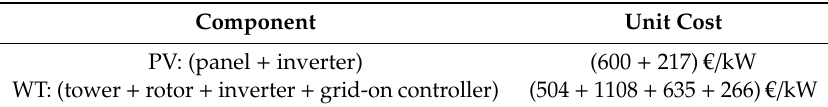
Table 2. Summary of unit costs.